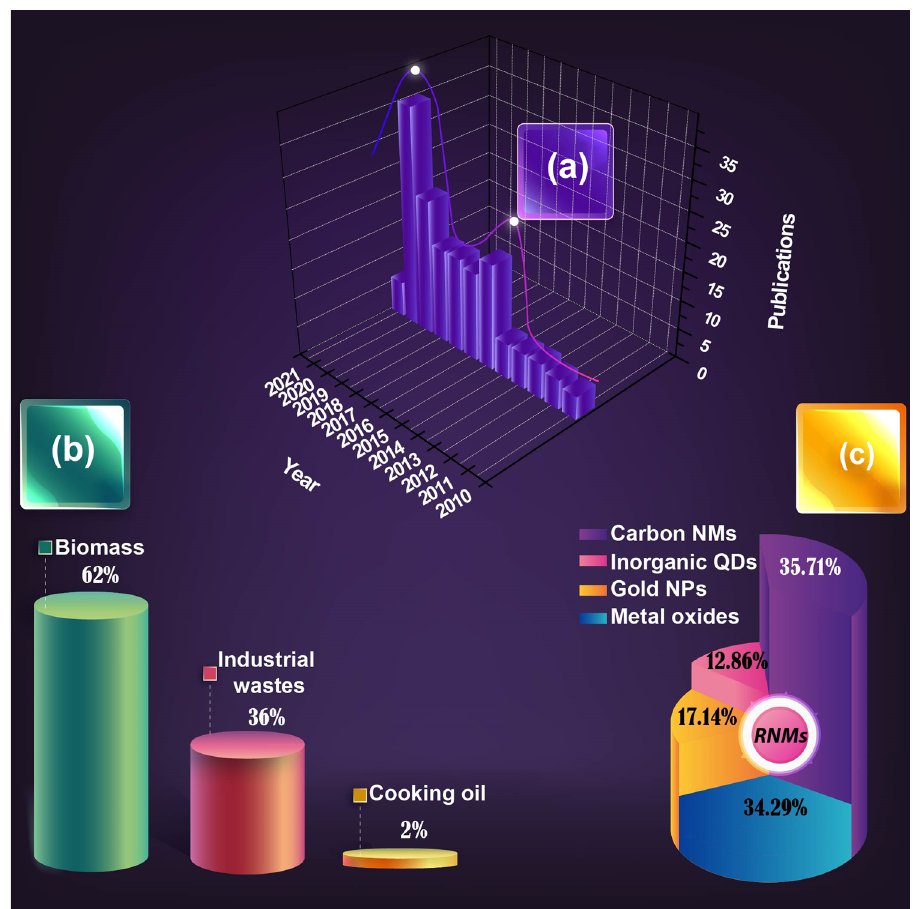
Figure 2: ( a ) Number of publications in the past ten years that address NMs ( CNMs, IQDs, and MOs ) recycled from biomass, cooking oil, and industrial wastes; ( b ) percentage according to waste type; and ( c ) percentage of each group of